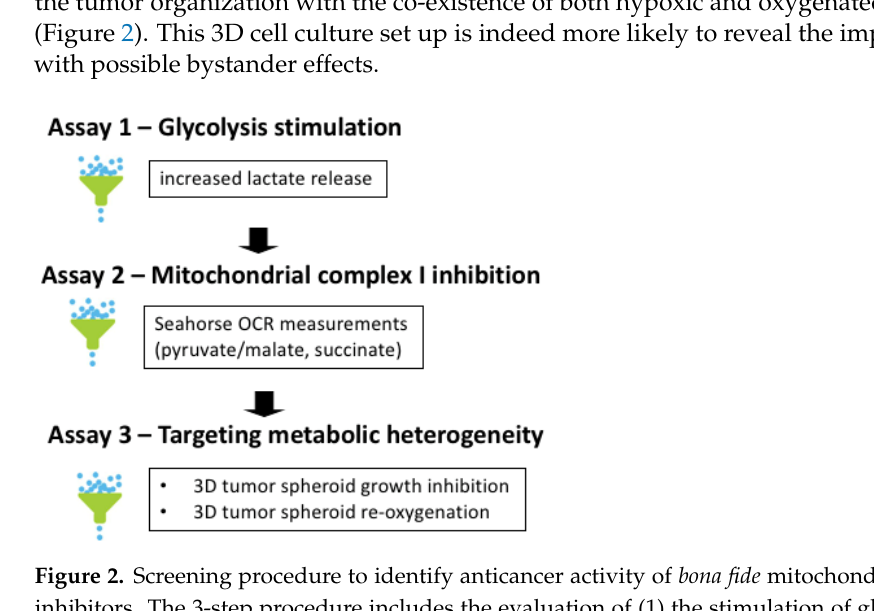
Figure 2. Screening procedure to identify anticancer activity of bona fide mitochondrial complex I inhibitors. The 3-step procedure includes the evaluation of (1) the stimulation of glycolysis upon OXPHOS inhibition (based on the increase in extracellular L-lactate release), (2) complex I inhibition (based on the measurement of real-time oxygen consumption rate (OCR) in permeabilized cancer cells exposed to a NADH-generating system and (3) the capacity to impact the growth of 3D tumor spheroids recapitulating tumor metabolic heterogeneity (through the determination of growth inhibitory effects, re-oxygenation and radio-sensitization).